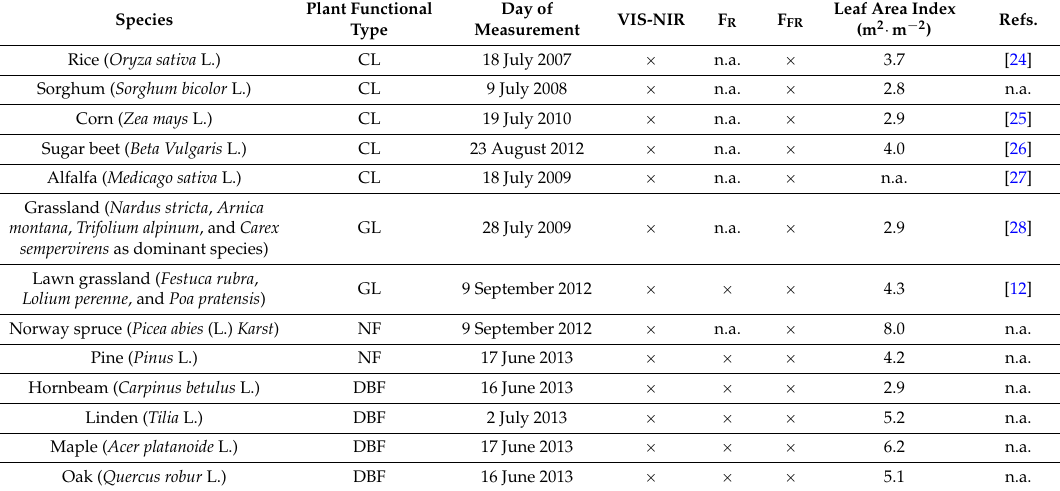
Table 1. List of the investigated species, plant functional types (CL: cropland, GL: grassland, NF: Needleleaf Forest, DBF: Deciduous Broadleaf Forest), day of measurements and the spectral range investigated: VIS-NIR refers to the visible-near infrared spectral region from 400 to 1000 nm, F R refers to the spectral region around the O 2 -B band (657–740 nm) and F FR refers to the spectral region around the O 2 -A band (700–800 nm). Leaf Area Index (m 2 ¨ m ´ 2 ) is also reported when available. n.a. is not available. The symbol ˆ denotes the availability of the